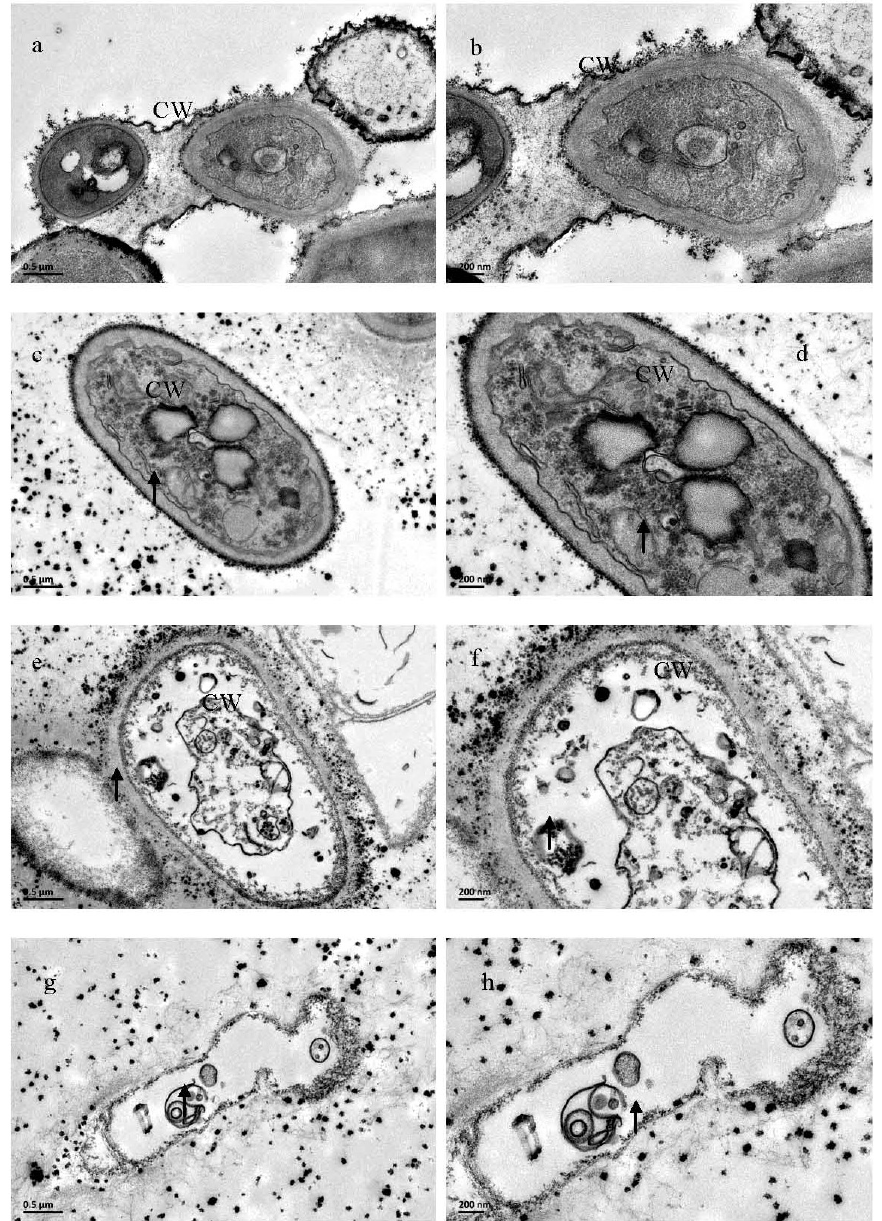
Figure 3. Transmission electron micrographs of M. grisea hyphae, where hyphae was exposed to agar with citral at ( a , b ) 0 μ g/mL, ( c , d ) 50.00 μ g/mL, ( e , f ) 100.00 μ g/mL, and ( g , h ) 200.00 μ g/mL. CW: Cell